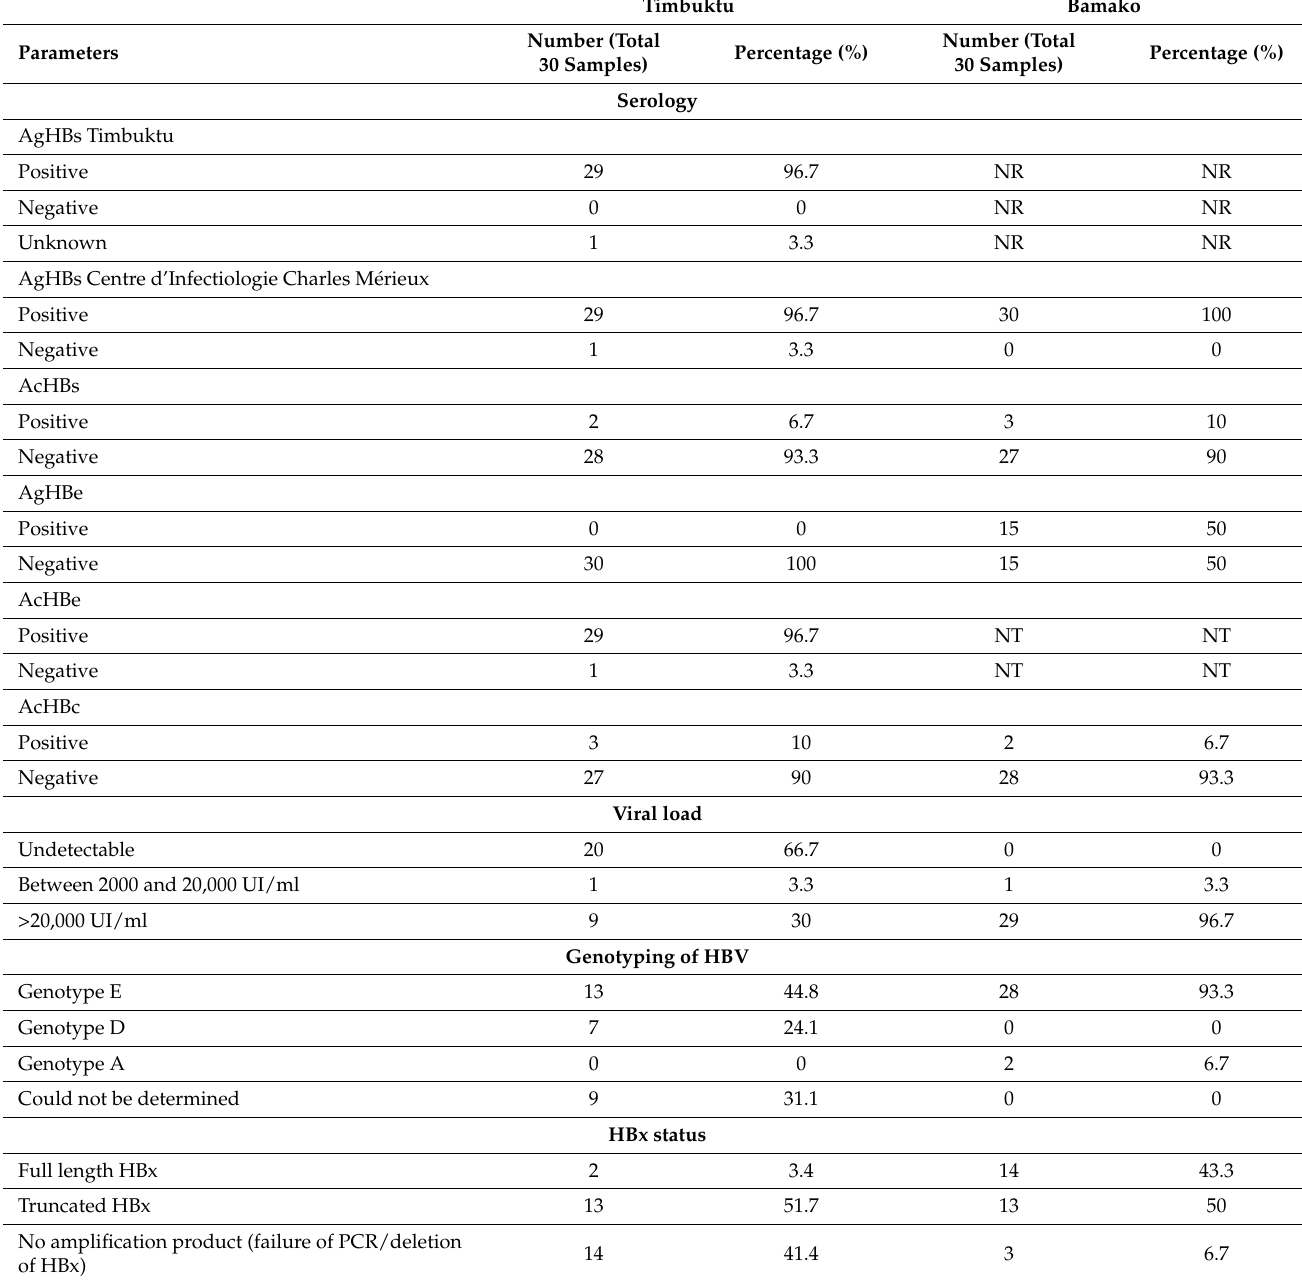
Table 2. Serology, viral load, genotyping and HBx status for AgHBs-positive volunteers from Timbuktu and Bamako